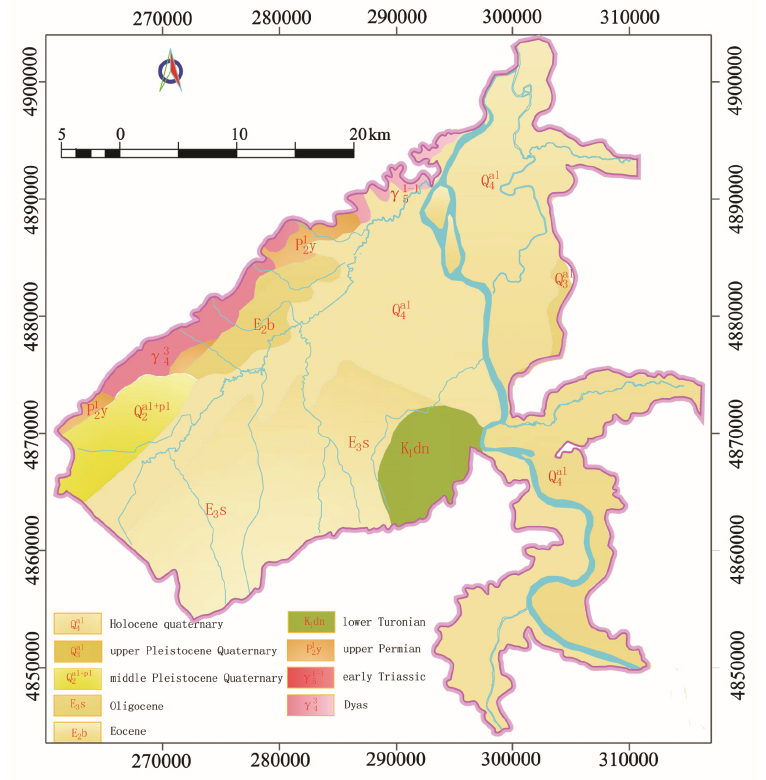
Figure 4. Geologic map of